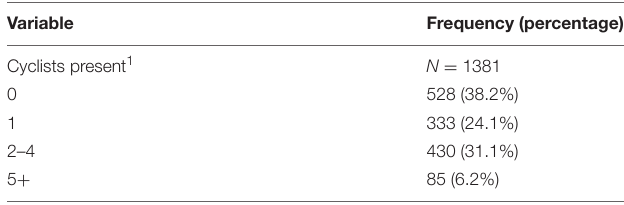
TABLE 2 | Frequencies and percentages of following behavior and cyclists present.